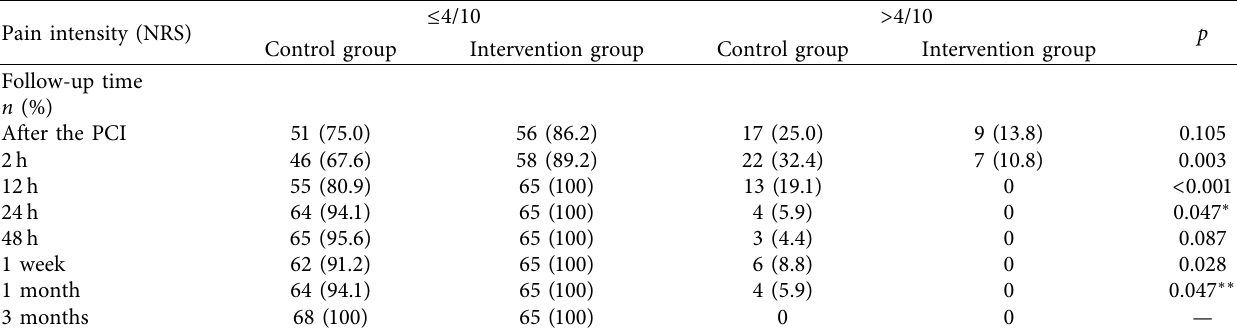
Figure 3: Multivariate comparison showing means of the pain intensity measures between groups (control and intervention) during a 3-month period. The X -axis (factor 1) shows time when pain intensity (NRS 0–10) was measured (1, after the procedure; 2, after 2h; 3, after 12h; 4, after 24h; 5, after 48h; 6, after one week; 7, after one month; 8, after 3 months) and the y -axis shows the mean points of the pain intensity. Wilks’ λ � 0.84 F (7,125) � 3.37, p � 0 . 002. IG: intervention group; CG: control group; NRS: numeric rating scale. Table 2: Access-site pain intensity prevalence during the follow-up period between control and intervention groups according to pain intensity subgroups: ≤ 4/10 and >